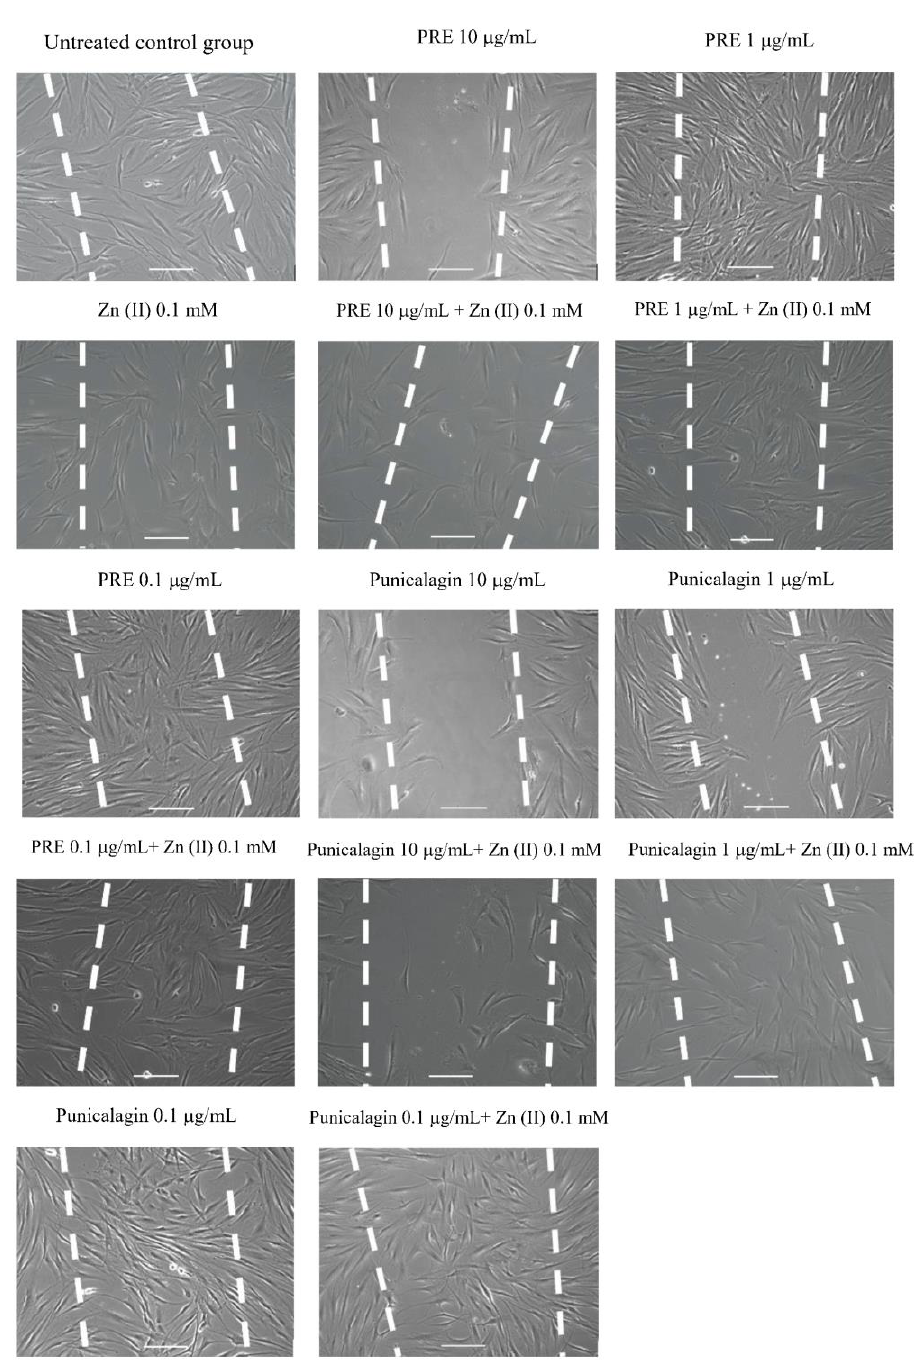
Figure 4. Representative time-lapse microscopy images of gingival fibroblast migration and wound repopulation at 48 h, following treatment with PRE and punicalagin (0.1–10 µ g / mL) alone and with 28.76 µ g / mL(0.1mM)Zn(II).Whitedashedlinesshoworiginalscratchwoundsat0h. Scalebar = 100 µ m.